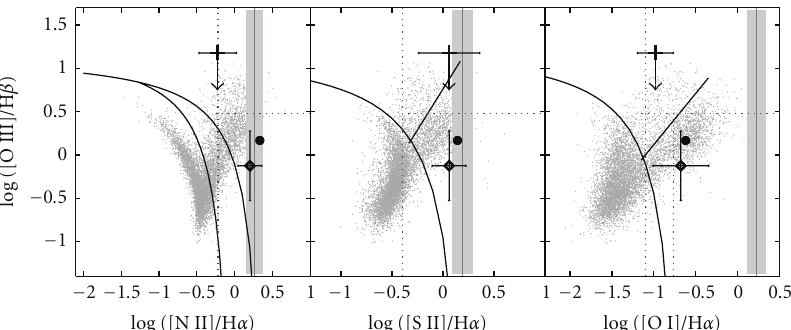
Figure 2: NGC 4736 within emission-line diagnostic diagrams. Filled circles reflect measurements based on the Palomar observations. Diamonds represent measurements from Moustakas and Kennicutt Jr. [45], while crosses show measurements from our MMT spectrum. The vertical bands indicate the HST -STIS measurements and the associated errors (with no correction for reddening; [OIII] and H β are not available in the HST spectra). The solid (black) curves indicate the Kewley et al. [6] classification, while the dotted (blue) lines indicate criteria used by Ho et al. [43]. The background grey points correspond to measurements of SDSS nearby galaxies from Constantin et al. [19].